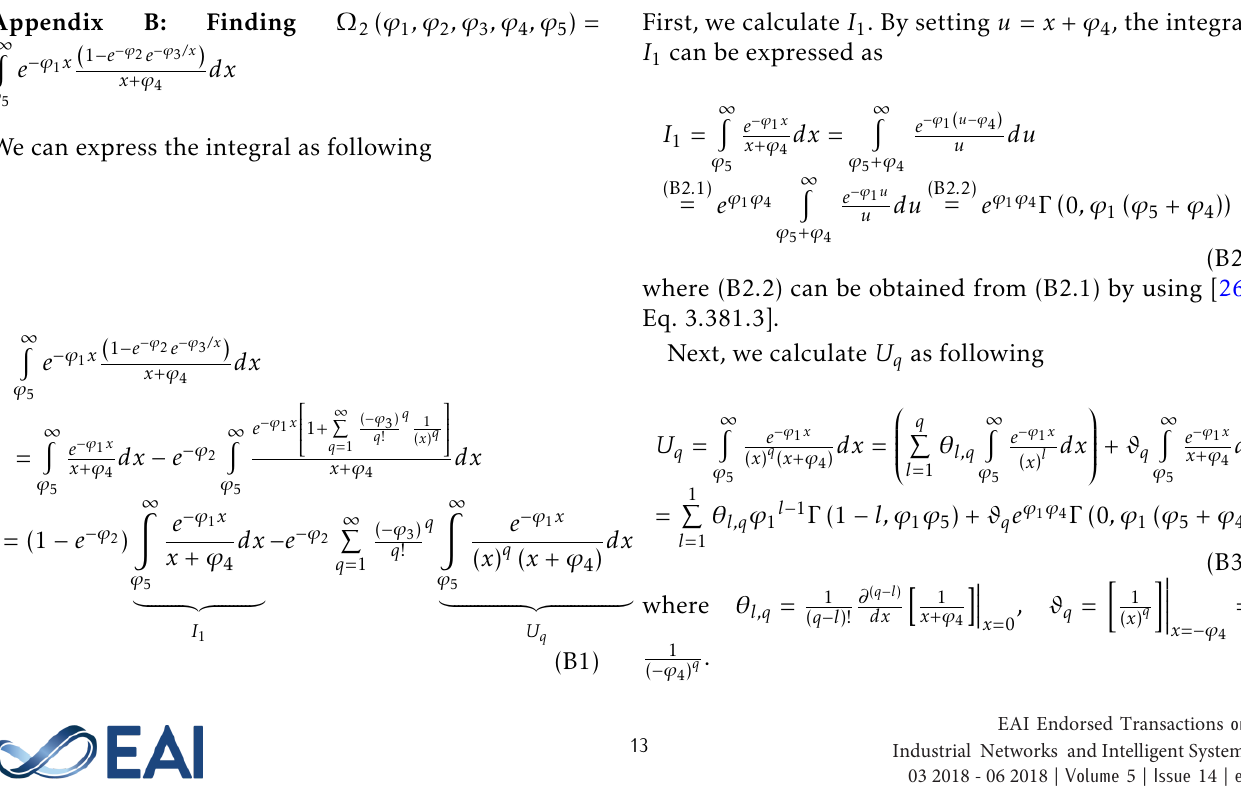
Figure 5. Outage probability versus x ( x R 1 , y R 1 ) = (0 . 5 , 0 . 3) , P = 5 dB, ψ t = 1 bits/s/Hz, ρ = 0 . 5 , η = 0 . 5 , M = 3 , and N = 3